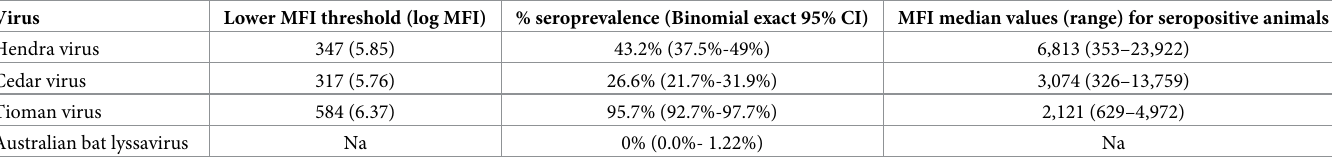
Lower thresholds including median fluorescence intensity (MFI) and log MFI and seroprevalence with confidence intervals (CI) for Hendra virus, Cedar virus, Tioman virus and Australian bat lyssavirus for Grey-headed flying foxes sampled in Adelaide, South Australia between September 2015 and February 2018 (n = 301). na = not